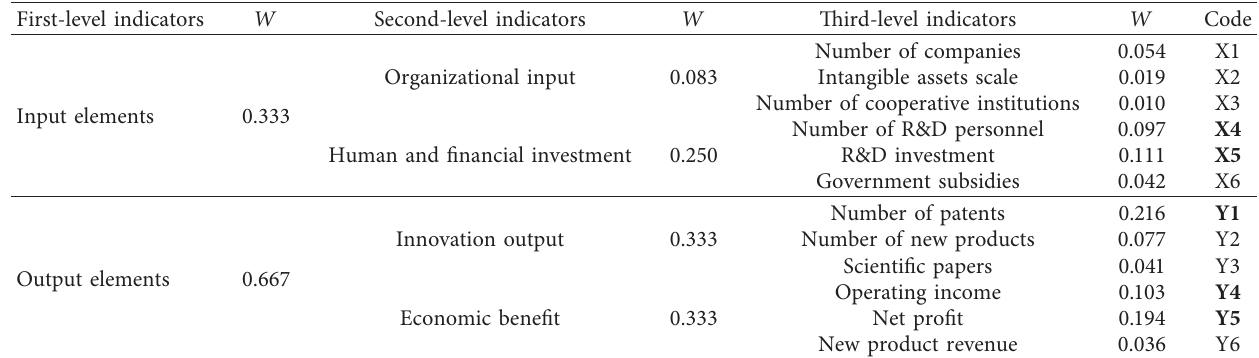
Table 8: Summary of indicator weights.